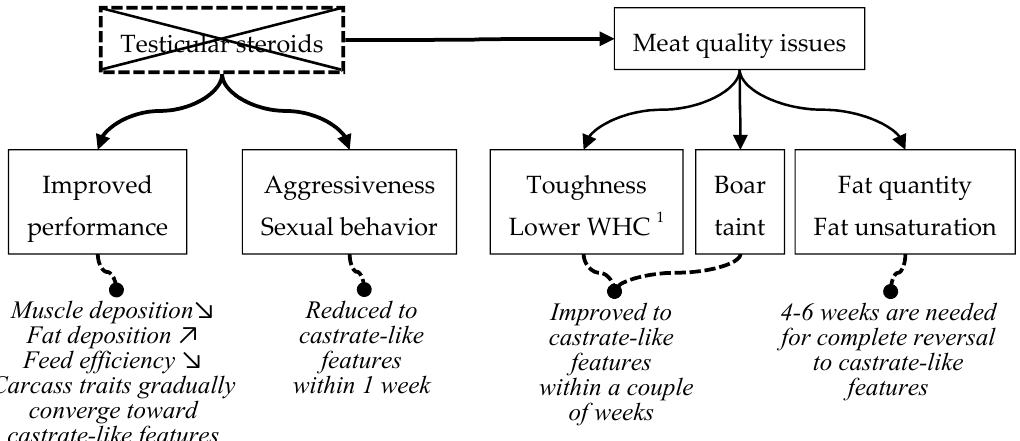
Figure 2. After the second vaccination, testicular steroid production is stopped, which results in dramatic changes in the metabolism of immunocastrates. Traits that are specific of entire males change to castrate-like features. Some traits are reversed more quickly than others ( 1 see Figure 1).